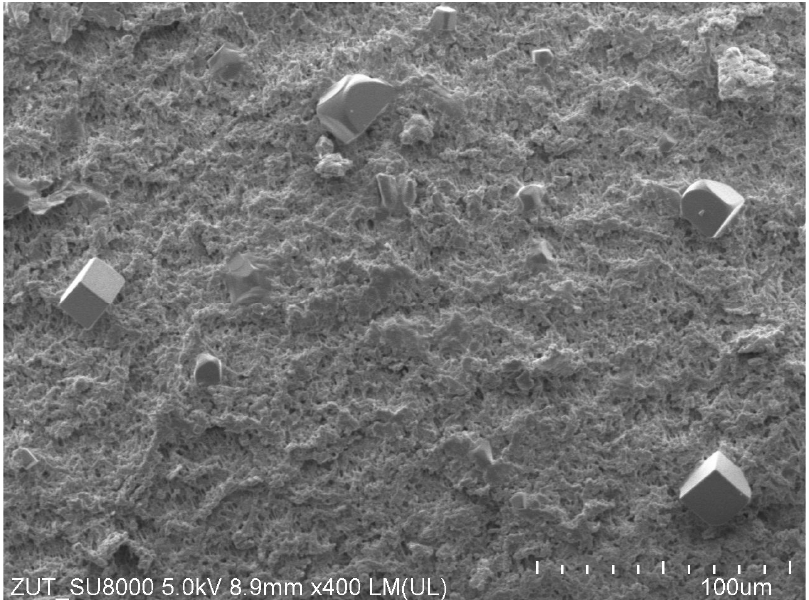
Figure 6. SEM images of V8 membrane surface with NaCl crystals. Sample collected from M2 module after 290 h operation of MDC installation.